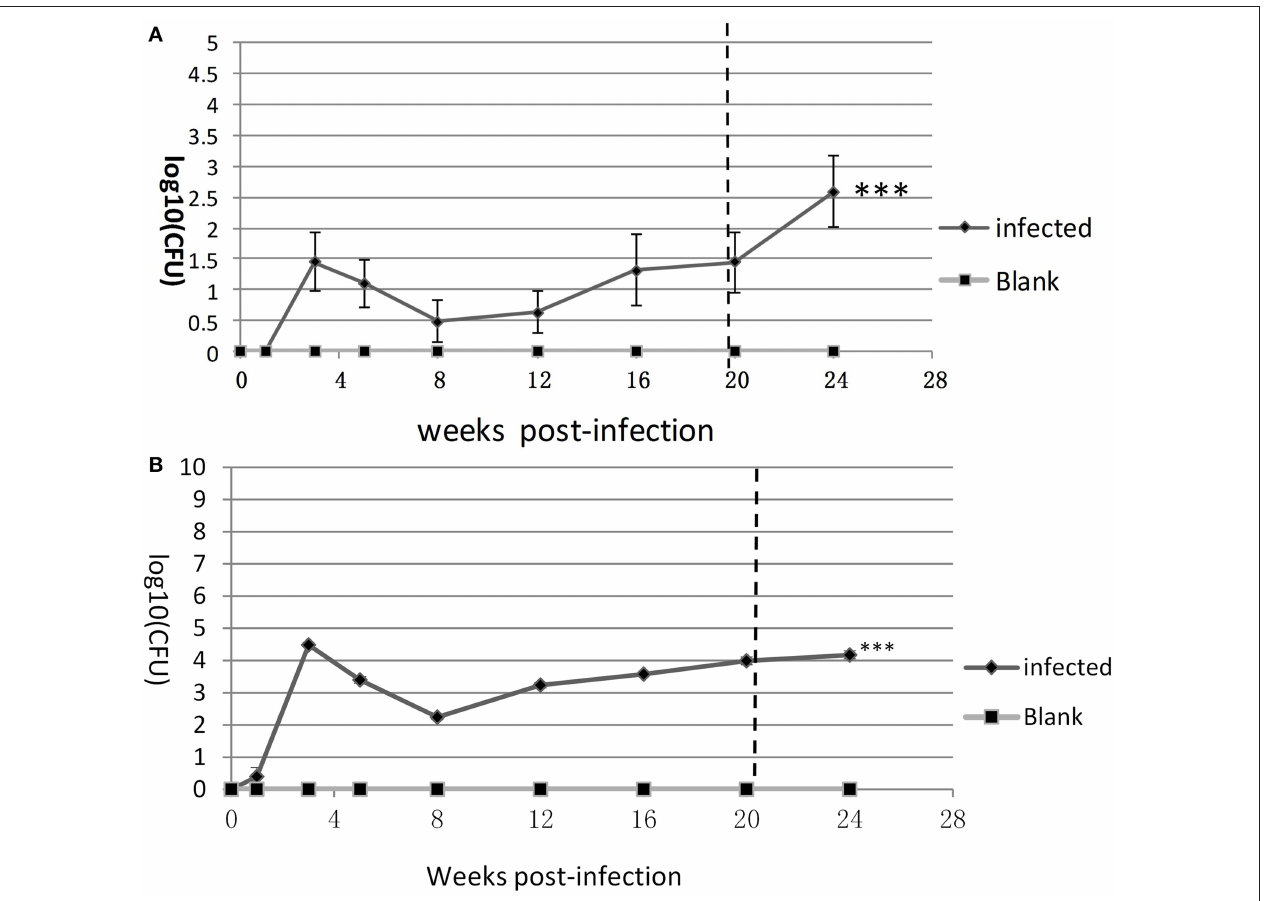
FIGURE 1 | The replication kinetics of M. tuberculosis in the lung and spleen. Bacterial loads (log 10 CFU) in (A) the lung and (B) spleen were counted on the L-J medium from week 1 to week 24. Six mice for each time-point in each group. One of three similar experiments is shown. The SEMs are plotted as error bars. T -test and ANOVA analysis, *** P < 0.001